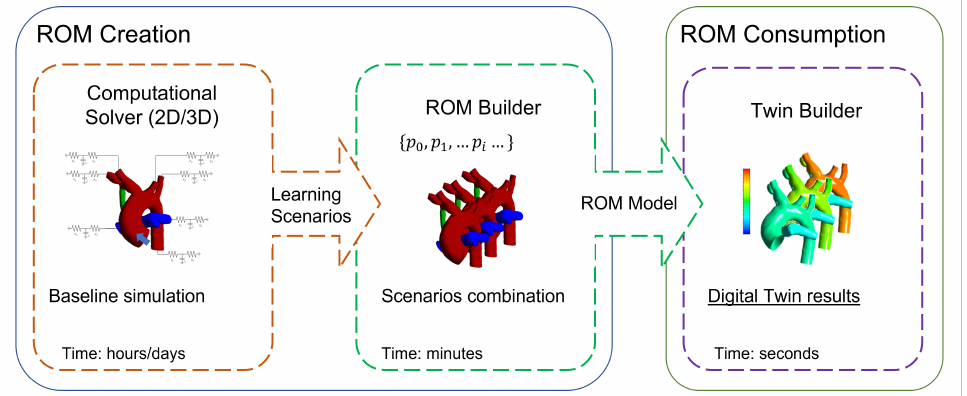
Figure 1. ROM workflow with the description of its main sections and the estimation of each step’s time